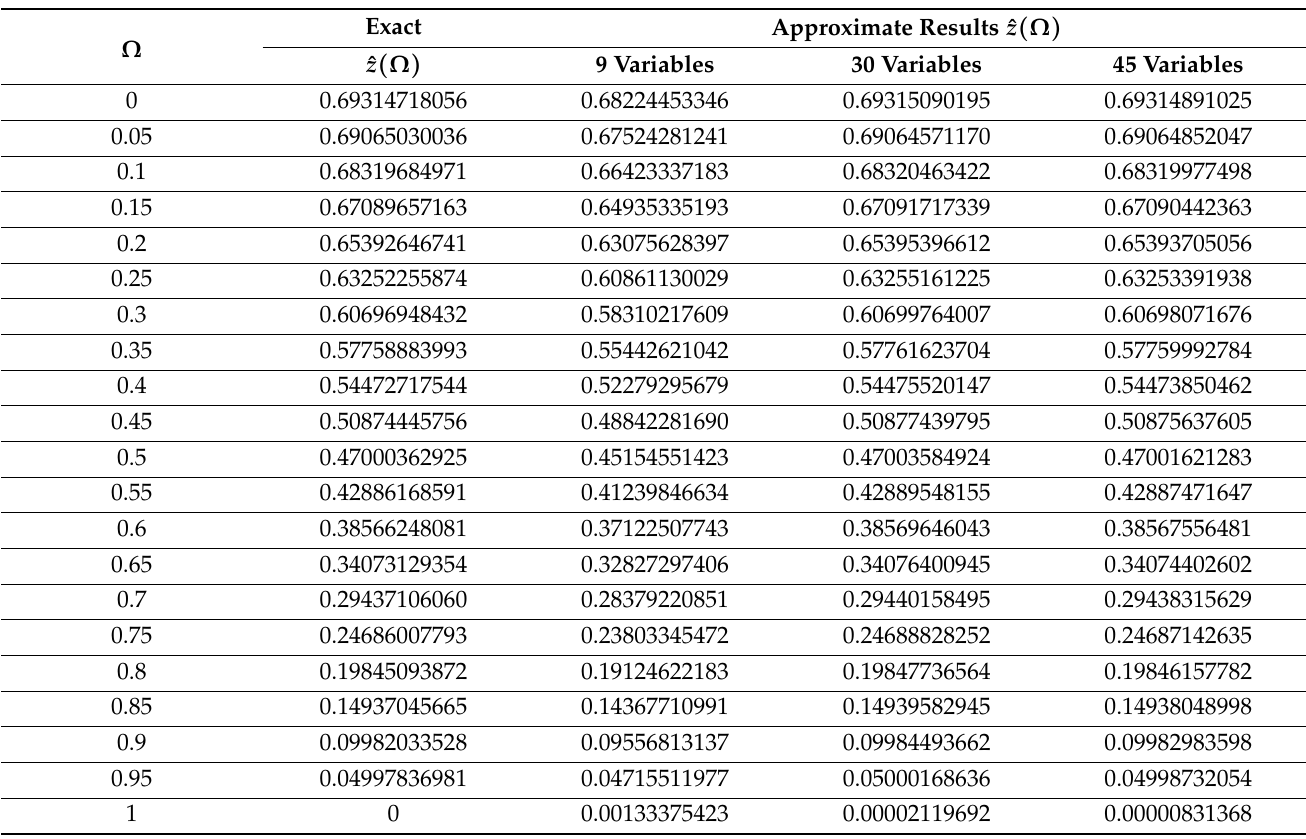
Table 2. Results comparison of Problem 1 based on ANN-GA-SQPM for three, 10, and 15 neurons, or nine, 30, and 45 variables with reference